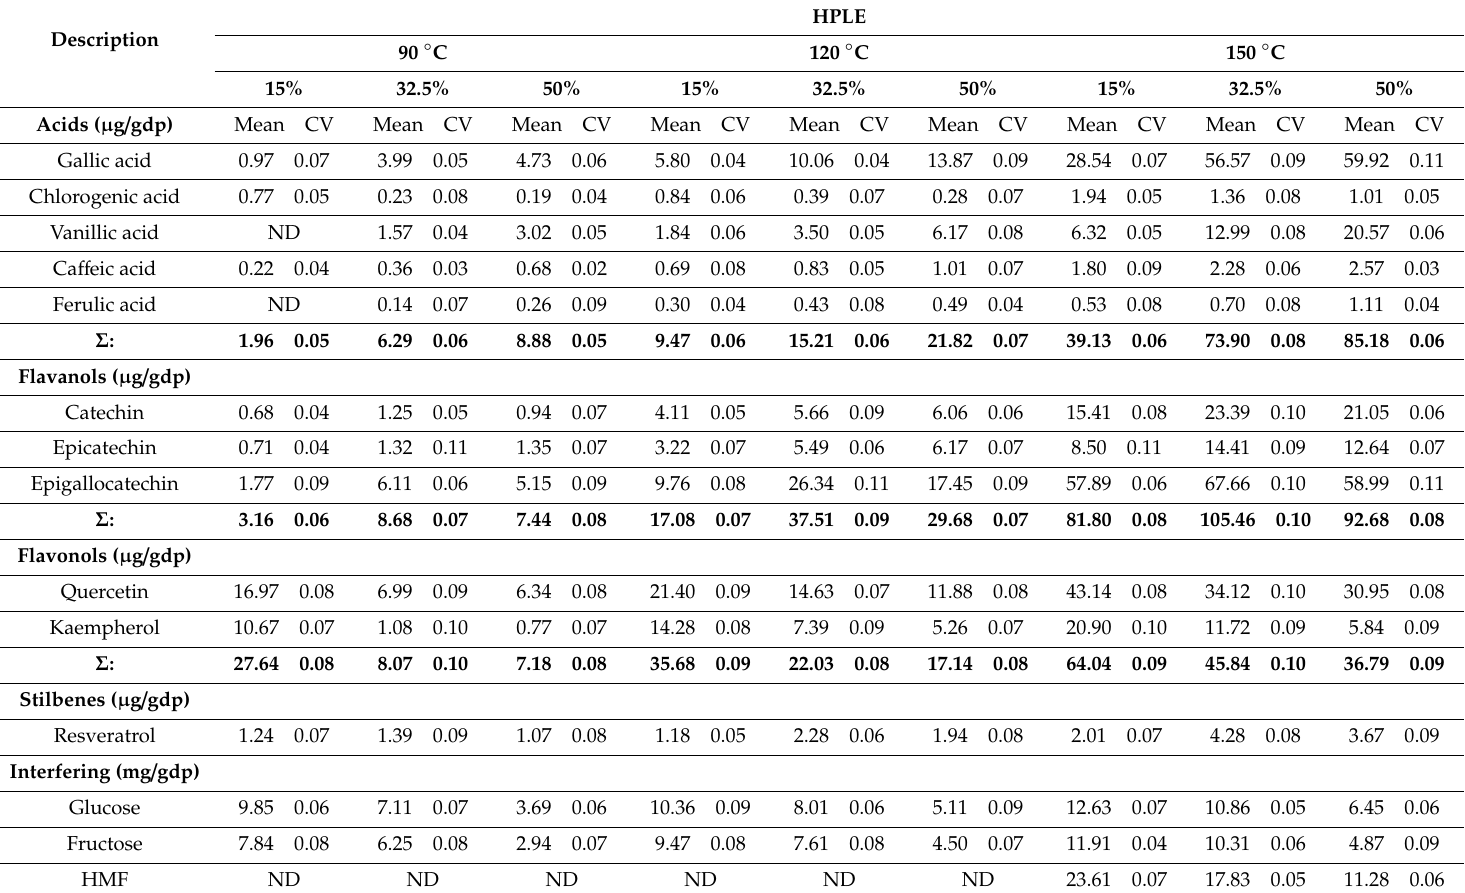
Table 2. Polyphenols profile of extracts obtained by hot-pressurized liquid extraction (HPLE)